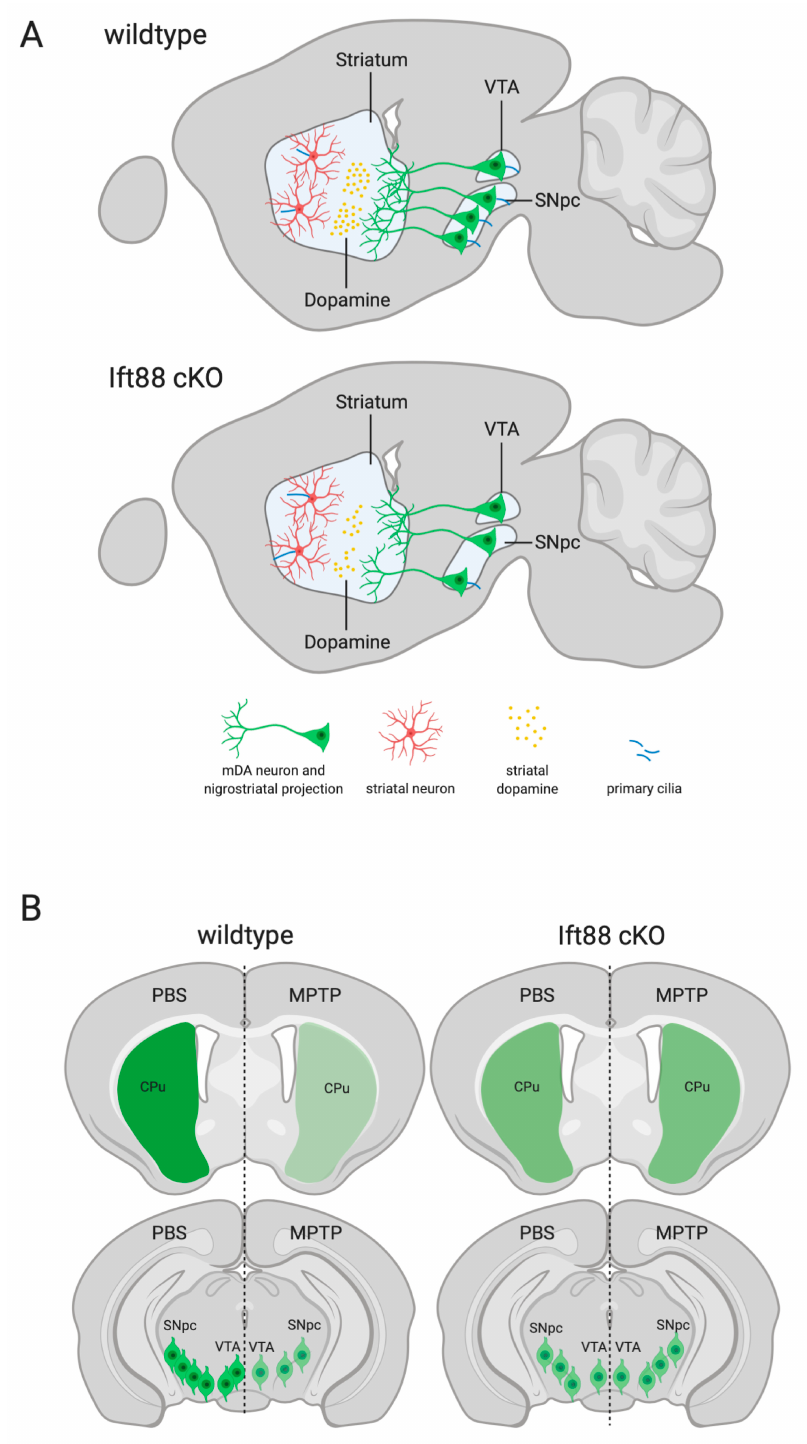
Figure 7. Summary of the effects of PC loss in DA neurons on striatonigral integrity. ( A ) In control mice, DA and striatal neurons are characterized by PC (in blue) and dopamine is released in the striatum (yellow circles) via DA projections. In the Ift88 cKO mice, the number of DA neurons showing primary cilia is drastically reduced, resulting in striatal neurons characterized by an increased length of primary cilia. ( B ) TH immunoreactivity (green) in the striatum and in SN DA neurons is reduced upon MPTP treatment and in the non-treated Ift88 cKO mice, but this is not exacerbated in the MPTP-treated Ift88 cKO mice. Abbreviations: Cpu, caudate putamen; SNpc, substantia nigra pars compacta.